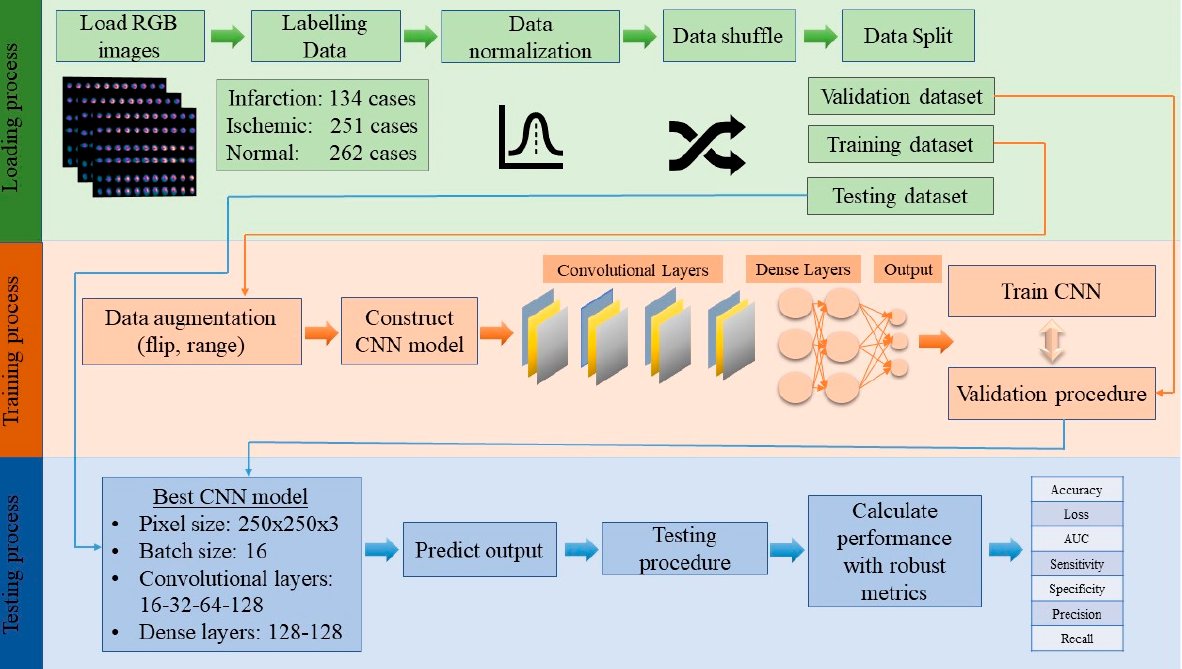
Figure 2. Steps of the proposed methodology.